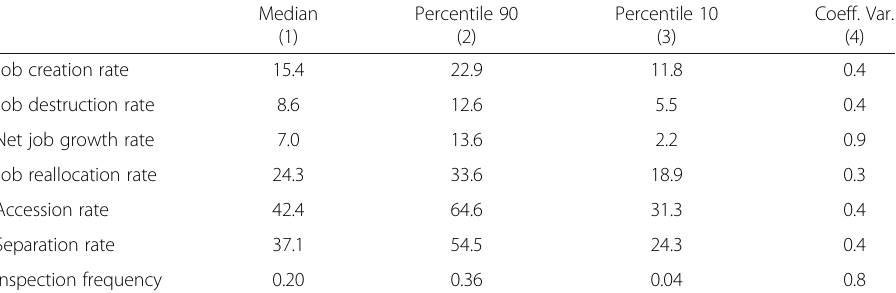
Table 5 Statistics for worker and job flows, inspection indicator, and establishment characteristics at the city